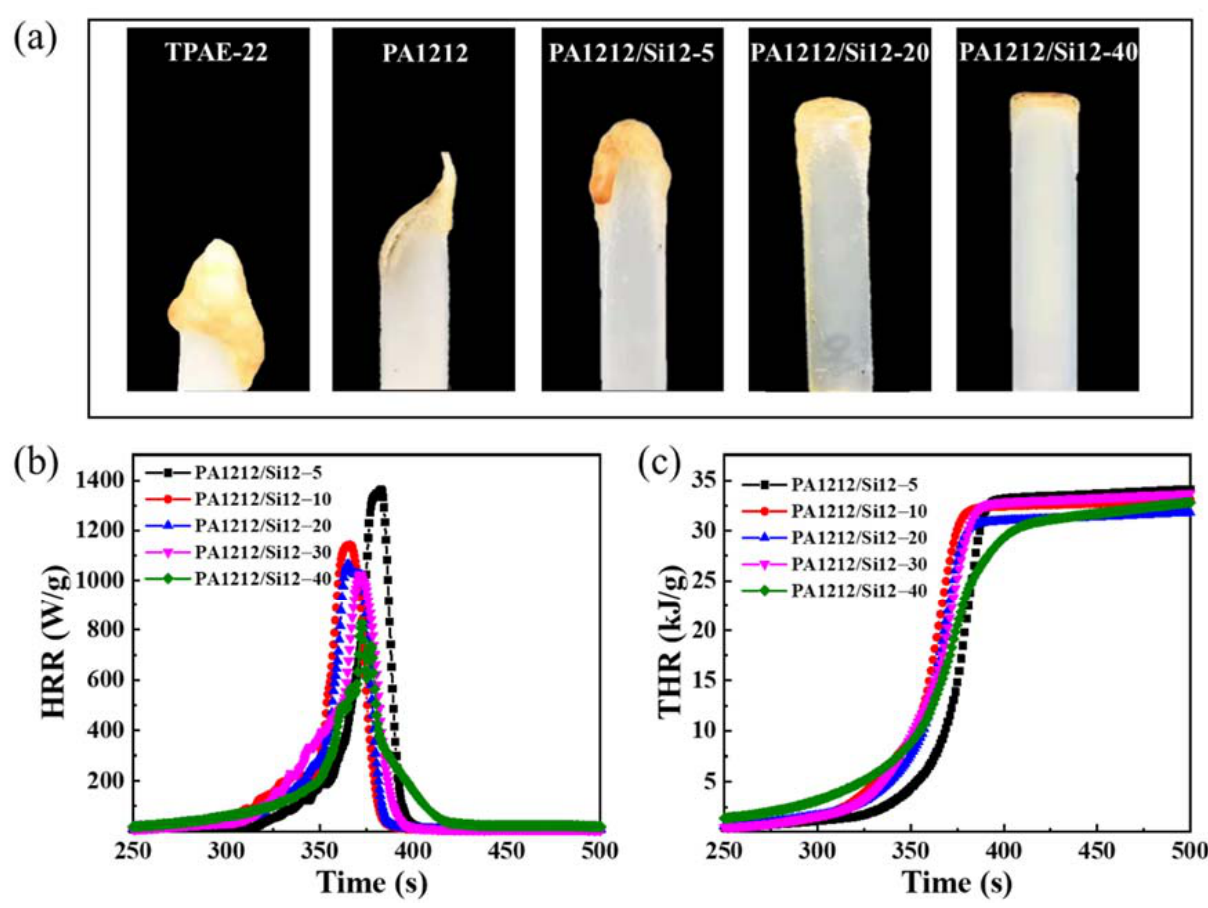
Figure 5. ( a ) Digital photographs of the samples after combustion; ( b ) HRR and ( c ) THR curves of PA1212/Si12 copolymers.